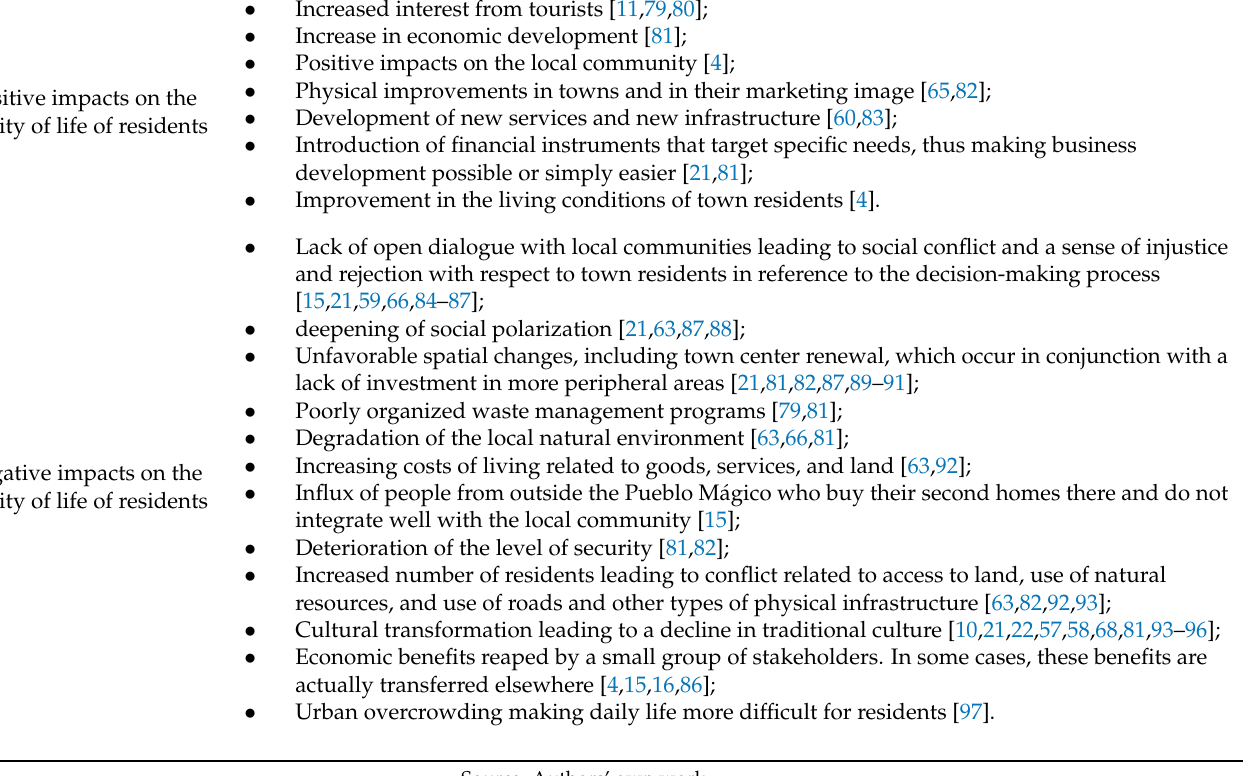
Table 3. Positive and negative impacts of the PPM on the quality of life of local residents.